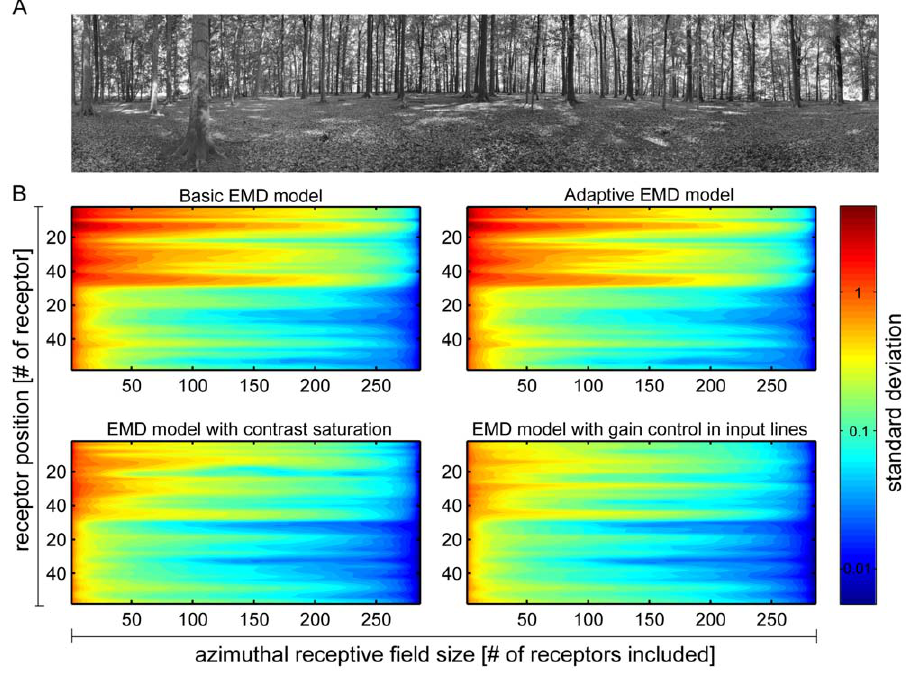
Figure 4. Pattern-dependent modulations of EMD models with one-dimensional receptive fields. (A) Panoramic high dynamic range input image II (Fig. 2) used exemplarily for stimulation. (B) Logarithmic color coded standard deviation describing the mean pattern-dependent modulation for one-dimensional receptive fields differing in vertical receptor position and azimuthal receptive field size ( # of receptors included horizontally) for all models. In all models pattern-dependent modulation amplitude decreases with horizontal receptive field extent. With increasing receptive field extent pattern-dependent modulations are reduced to a higher extent in models with contrast saturation (C&D). Further, pattern- dependent modulation amplitude depends on the contrast distribution of the input image, as can be seen, when comparing pattern-dependent modulation amplitudes corresponding to the upper (trees) and lower part (ground) of the input image.